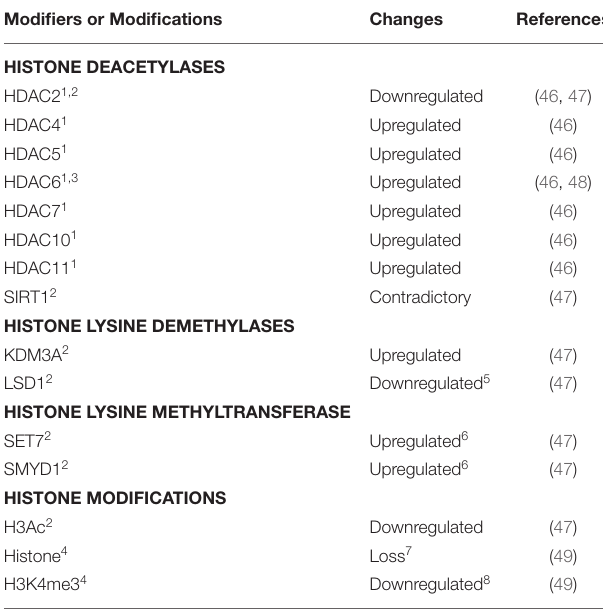
TABLE 1 | Changes of histone modifications and modifiers in DOX treated